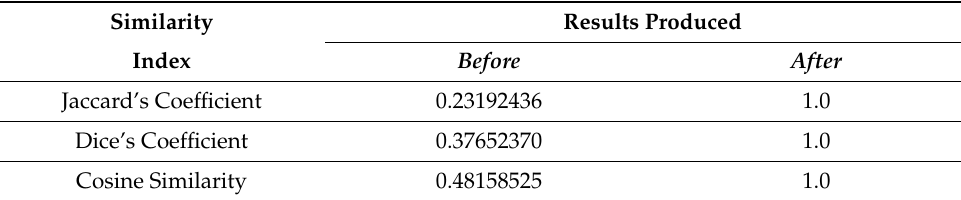
Table 1. Similarity Measure for documents compared in Figure 15.